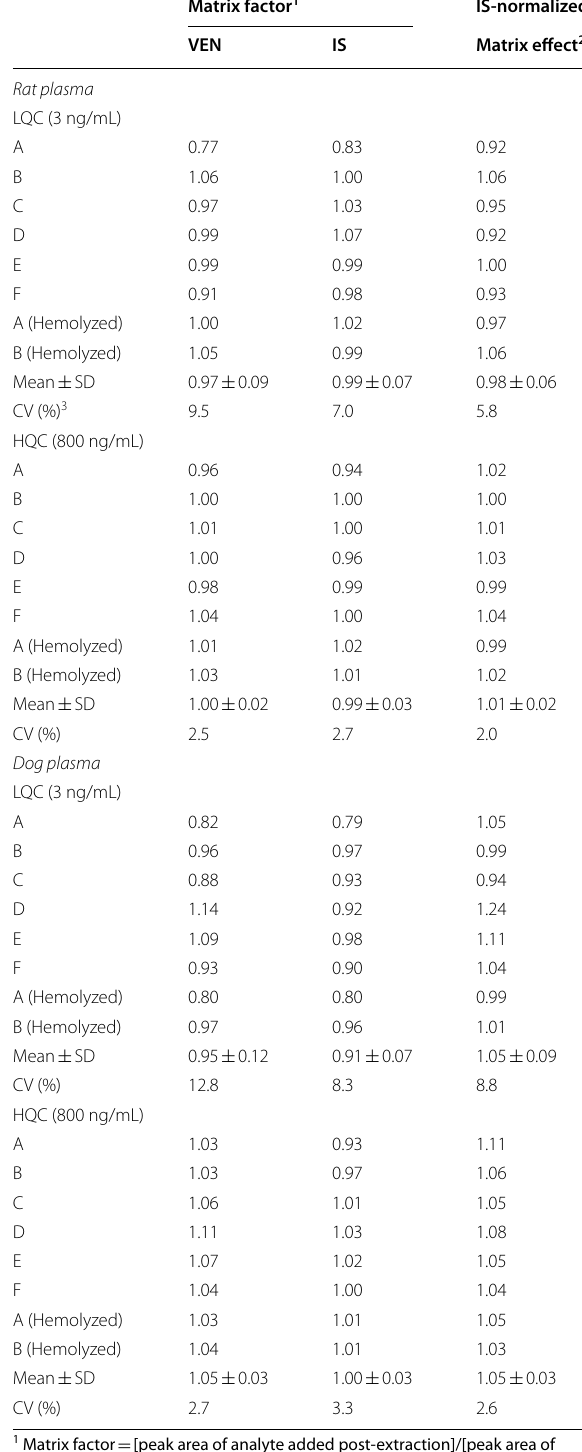
rat and dog Matrix factor